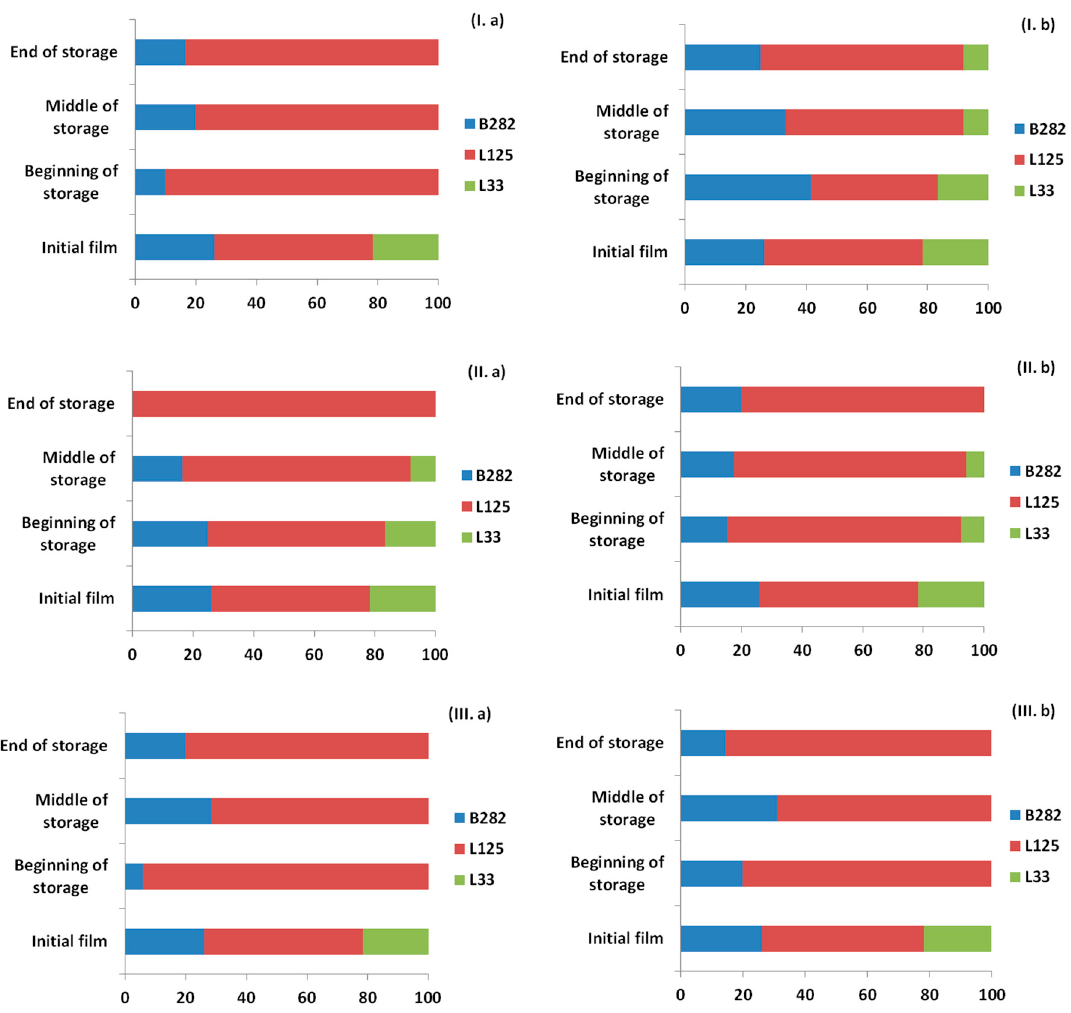
Figure 6. Distribution of isolates (%) of probiotic strains recovered films in contact with ham slices in three time points (beginning, middle and end) during storage at: 4 °C ( I) ; 8 °C ( II ); and 12 °C ( III ); and ( a ) without HPP; or ( b ) with HPP treatment based on the PFGE profiles.